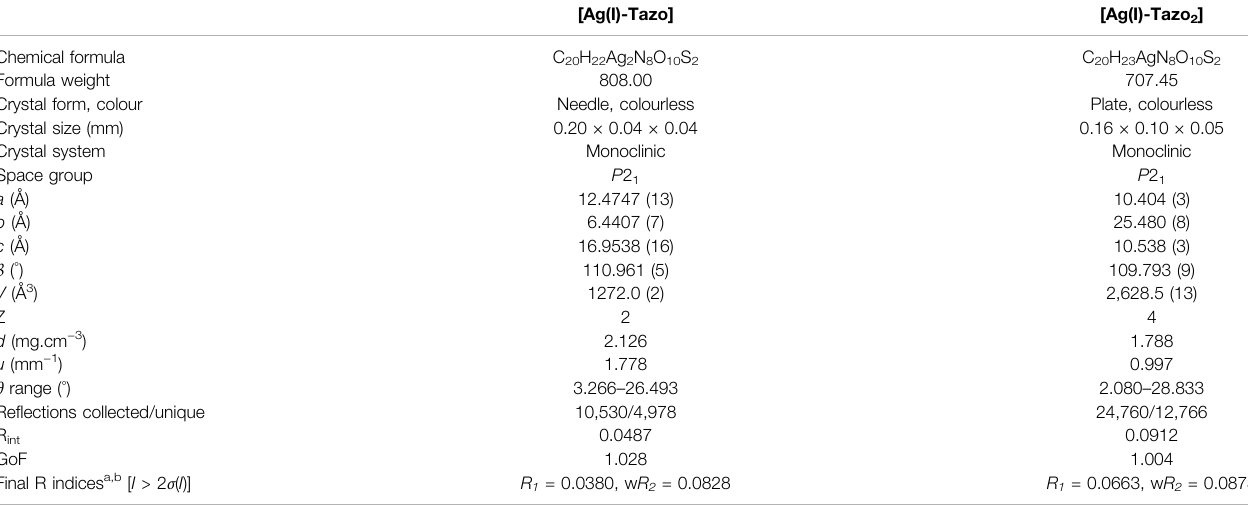
TABLE 4 | Crystallographic data for compounds [Ag(I)-Tazo] and [Ag(I)-Tazo 2